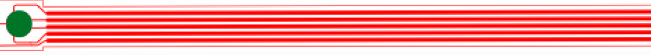
Figure 24. A prototype shear sensor drawing.